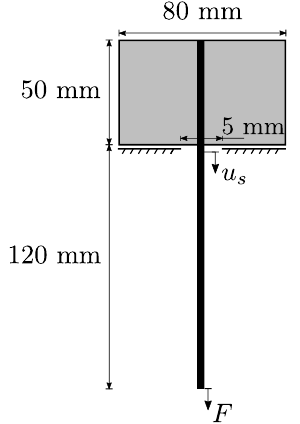
Figure 10. Schematical setup of simulated yarn pullout